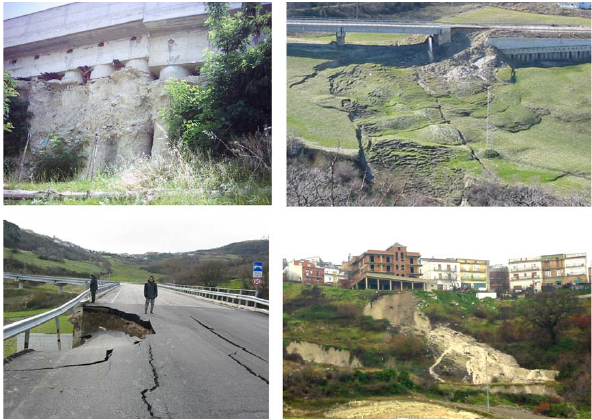
Figure 2. Damages and failures at Volturino (FG) where housing areas and infrastructures are 2 Fig. 2. Damages and failures at Volturino (FG) where housing areas continuously threatened by landslides. 3 and infrastructures are continuously threatened by